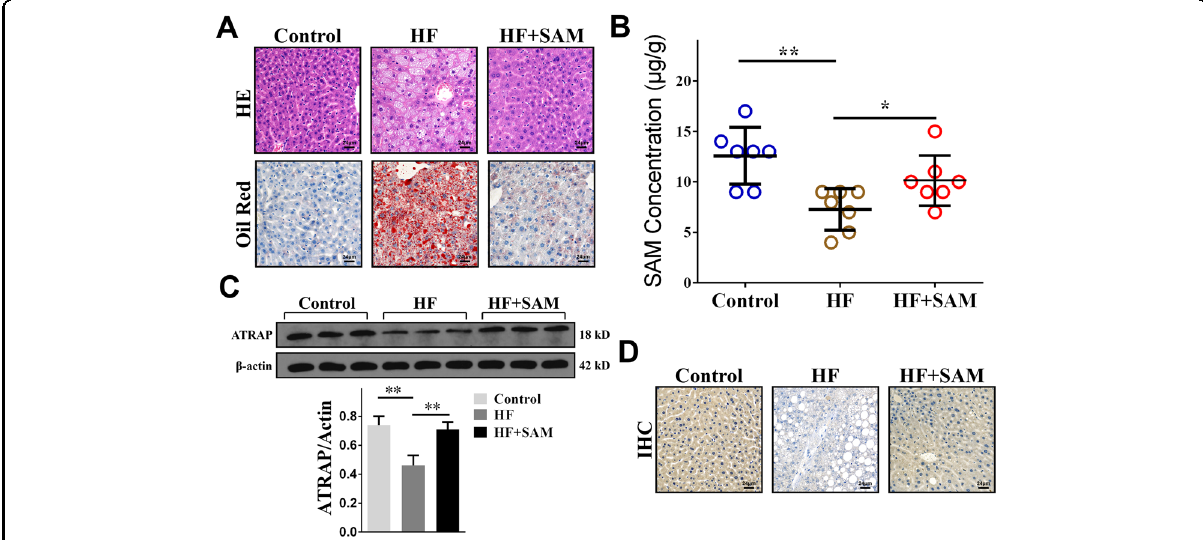
Fig. 2 SAM could inhibit the downregulation of ATRAP expression in NAFLD. A Images of liver tissues of rats from the control, HF, and HF plus SAM groups stained with HE and Oil Red O (bar = 24 μ m). B SAM concentrations in the liver tissues of rats in the control, HF, and HF plus SAM groups, as determined by UPLC. C ATRAP protein levels in the liver tissues of rats from different groups, as determined by western blotting and D immunohistochemistry (bar = 24 μ m). The error bars are the SDs ( n = 3). * P < 0.05, ** P <